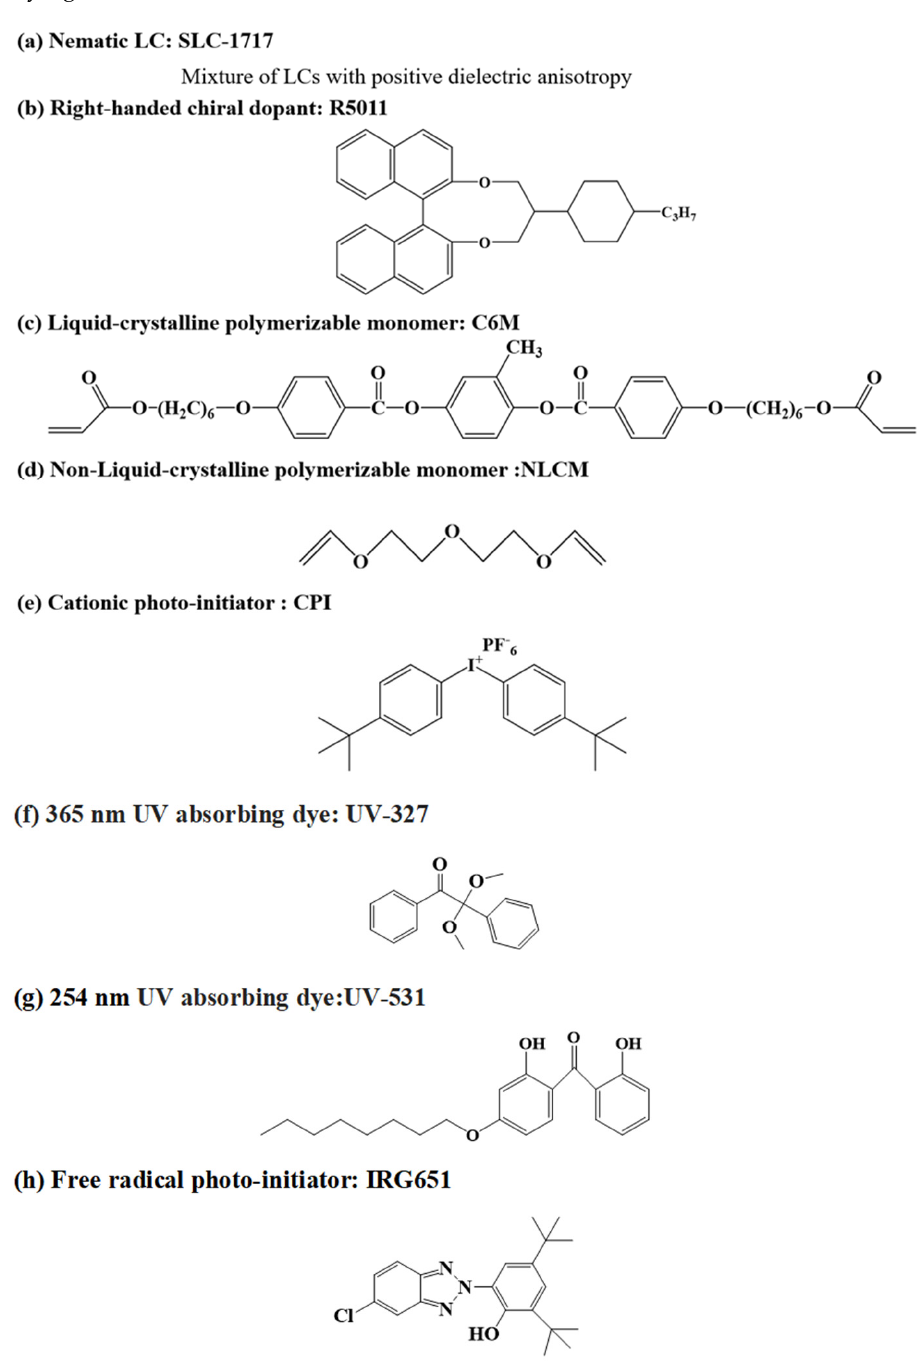
Figure 1. Chemical structure of the materials used.